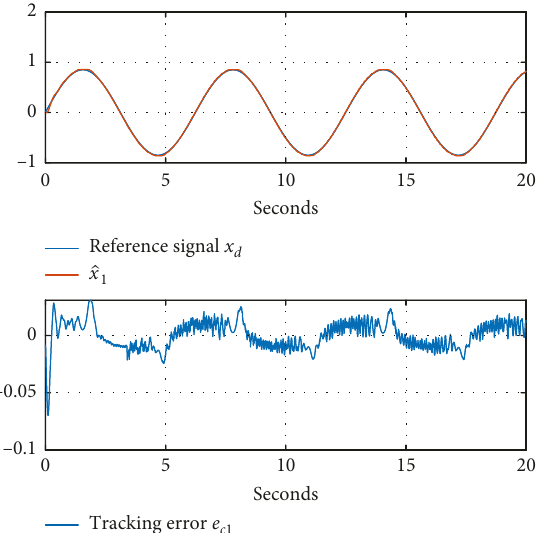
Figure 11: Tracking effect and tracking error.